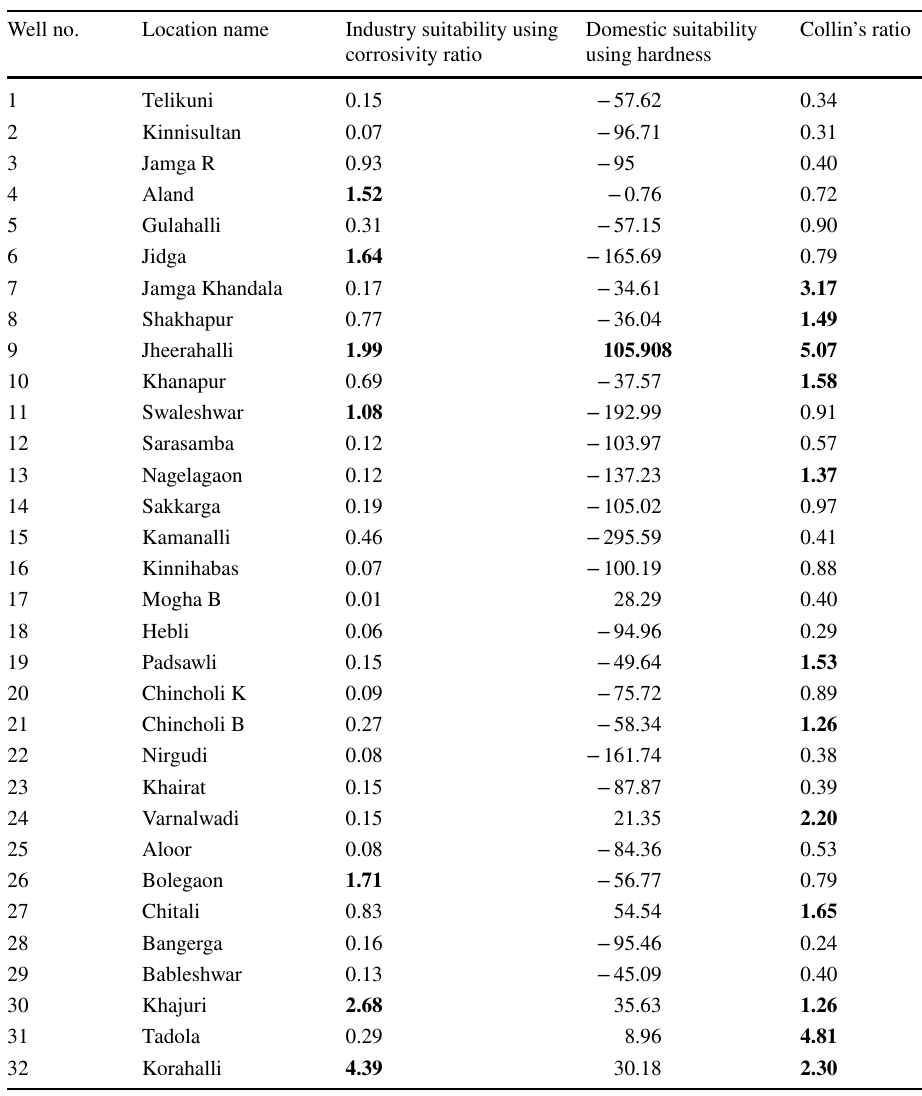
Bold values are representing the ‘higher concentration’ of the parameters Minus sign indicating the soft water using hardness (as CaCO